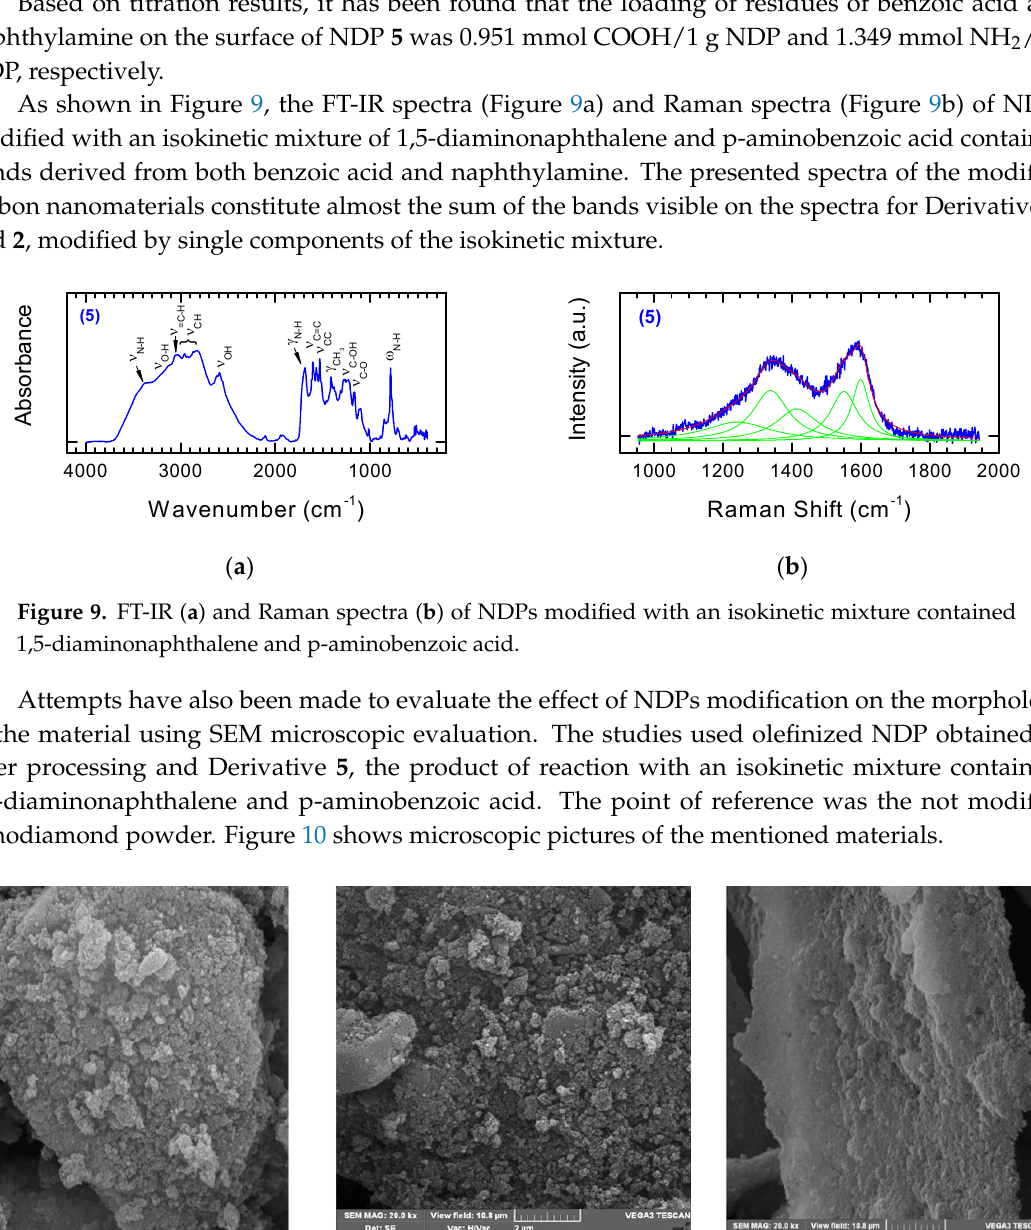
Figure 8. Reaction of olefinated NDPs with an isokinetic mixture of 1,5-diaminonaphthalene and p-aminobenzoic acid.